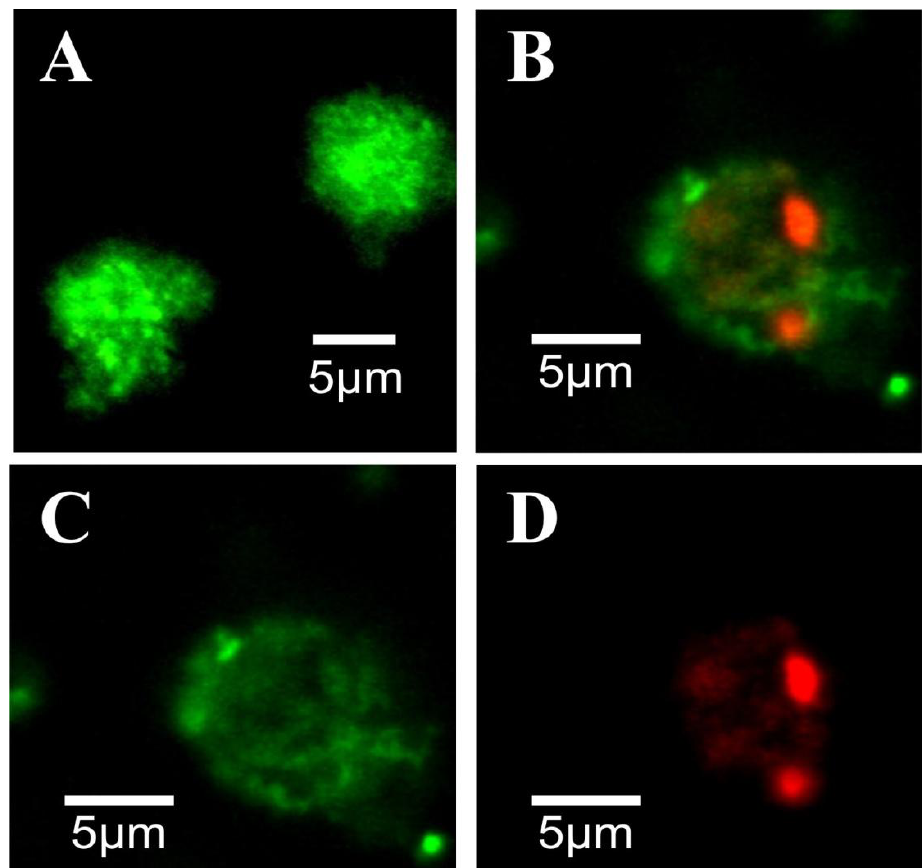
FIGURE 3. Difference in subcellular localization of vesicle-derived components and phagocytosed zymosan. Neutrophils were incubated with FITC-labeled V (A) or together with AF633-labeled zymosan (B–D) and processed for confocal microscopy analysis as described in the Materials and Methods section. Representative images of the dual-label experiments are shown with an overlay of the red and the green channels (B), and the respective single-channel recordings (C,